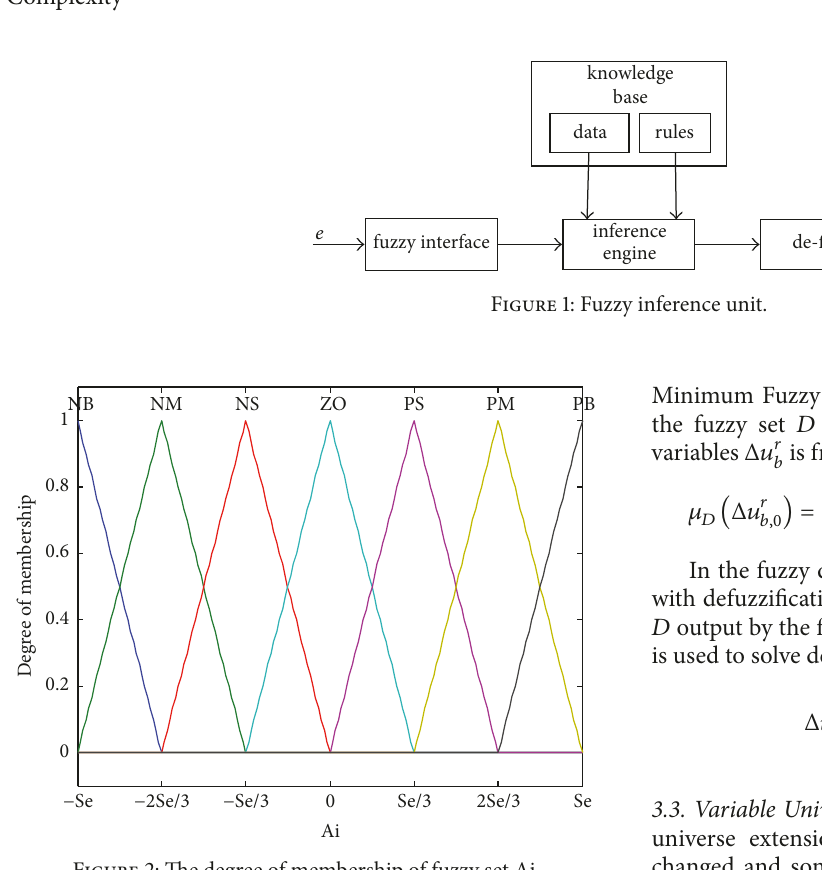
Figure 2: The degree of membership of fuzzy set Ai.